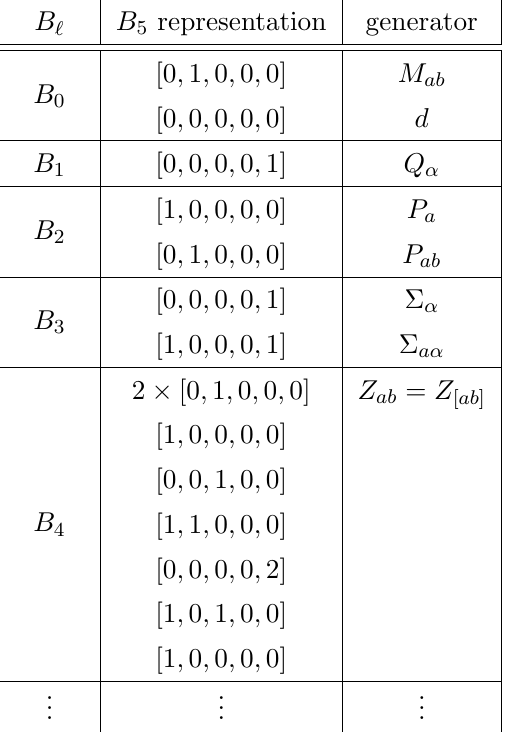
The non-negative levels of the Borcherds superalgebra de(cid:12)ned by the Dynkin diagram of (cid:12)gure 5. This is a quotient of the free Lie superalgebra shown in table 4 and the notation is as in that